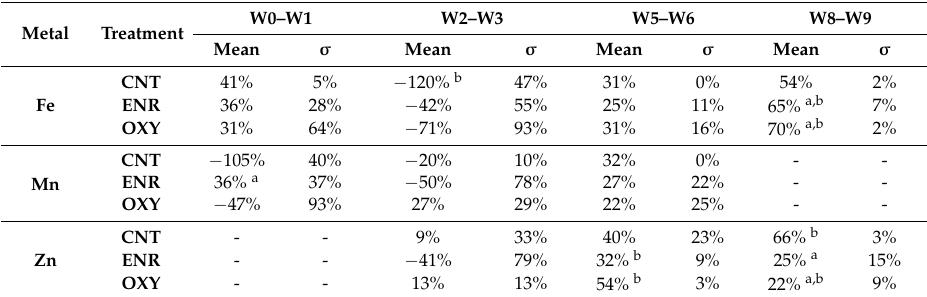
Table 2. Metals (Fe, Mn and Zn) removals, in percentage, during the experiment. Wastewater not doped (CNT) or doped with the antibiotic enrofloxacin (ENR) or oxytetracycline (OXY). W0–W1 W2–W3 Metal Treatment